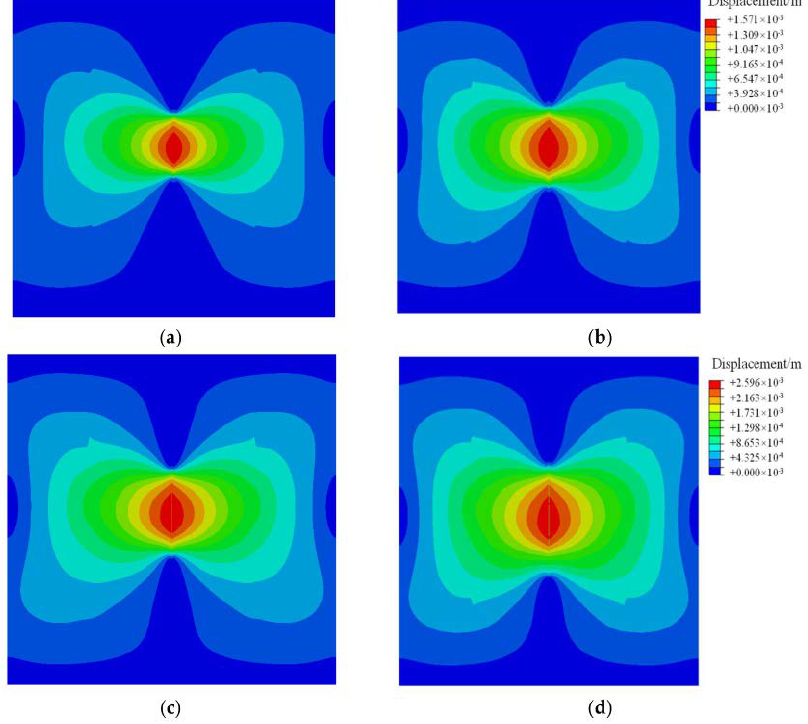
Figure 18. Cloud picture of displacement field under different injection rates: ( a ) injection rate of 3 m 3 /min and t = 55 s; ( b ) injection rate of 3 m 3 /min and t = 100 s; ( c ) injection rate of 6 m 3 /min and t = 55 s; and ( d ) injection rate of 6 m 3 /min and t = 100